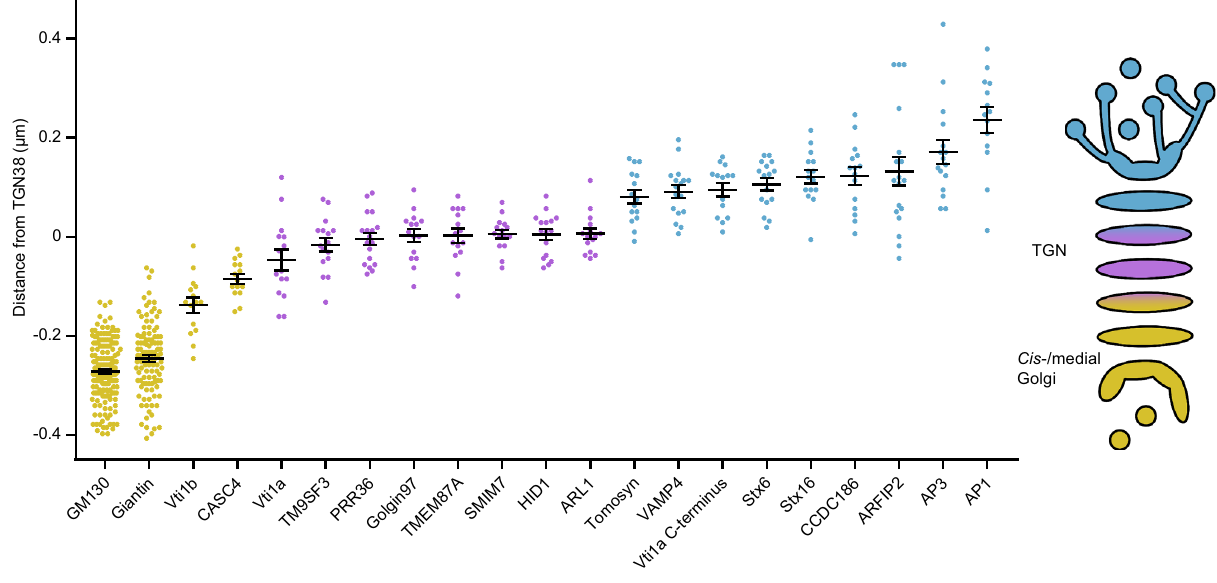
Figure 5. Overview of Golgi protein distribution relative to TGN38. Proteins upstream of TGN38 are shown in yellow, proteins overlapping with TGN38 in magenta and proteins downstream of TGN38 in cyan. Bars show mean ±